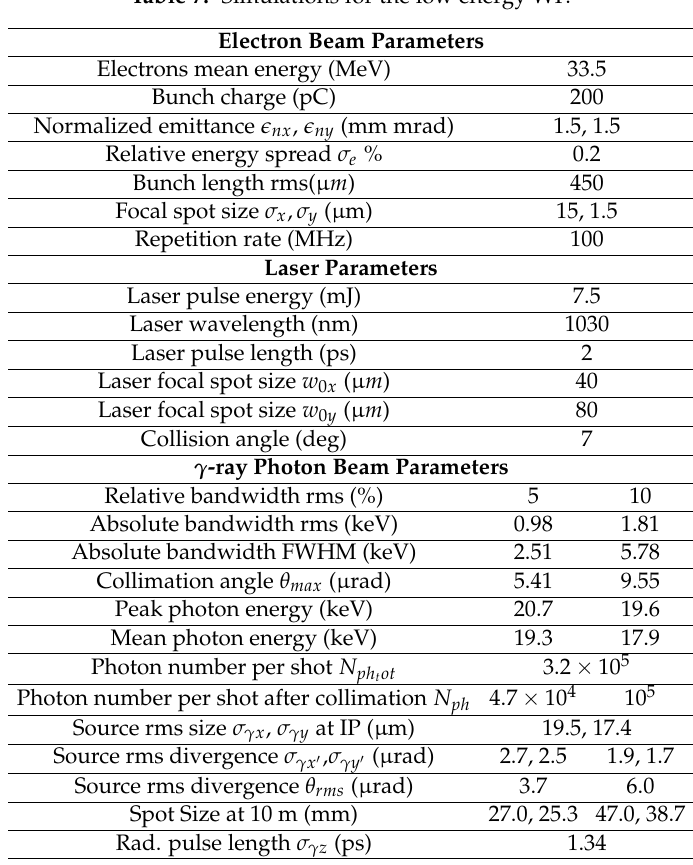
Table 7. Simulations for the low energy